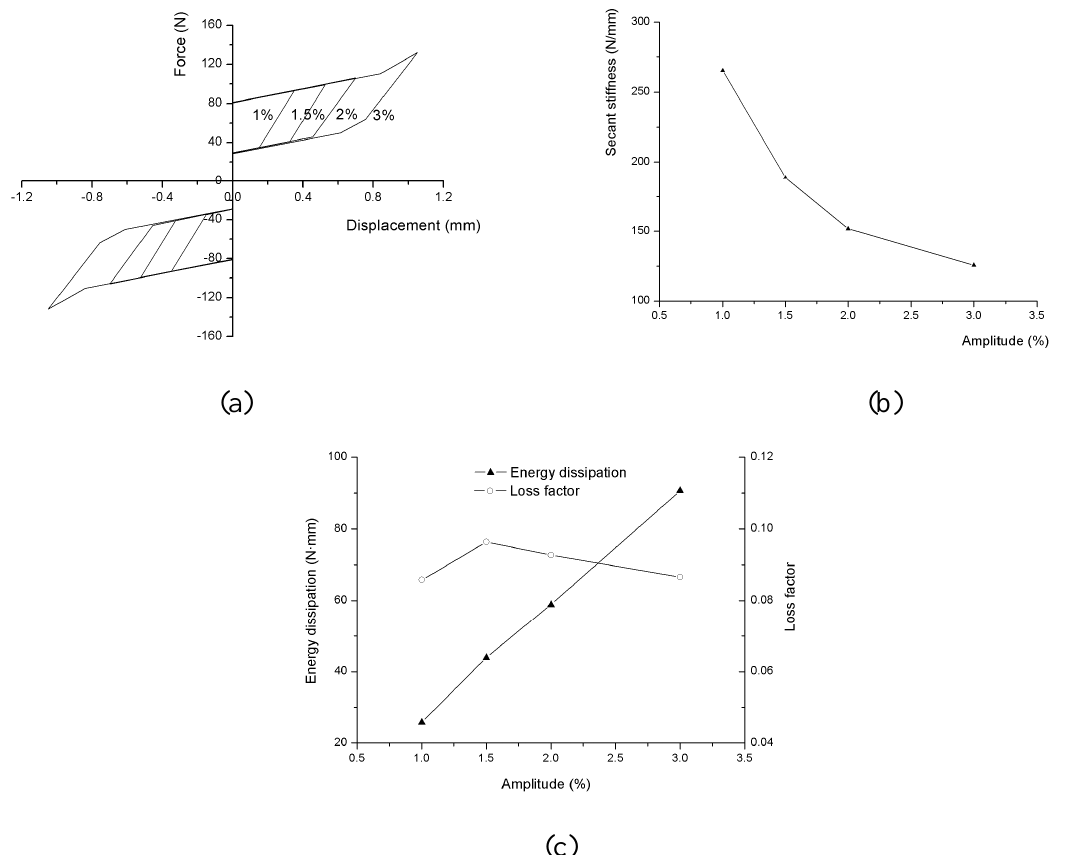
Figure 14 . Mechanical behavior of damper with strain amplitude variation: (a) Schematic diagram of the force-displacement curve; (b) Secant stiffness; (c) Dissipated energy and loss